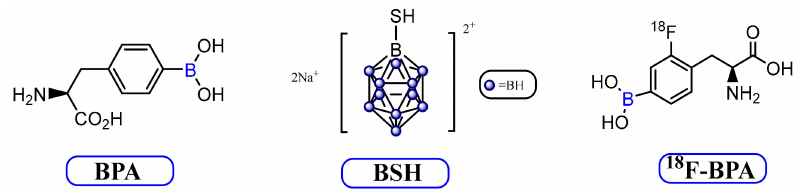
Figure 3. Structures of BPA, BSH and 18